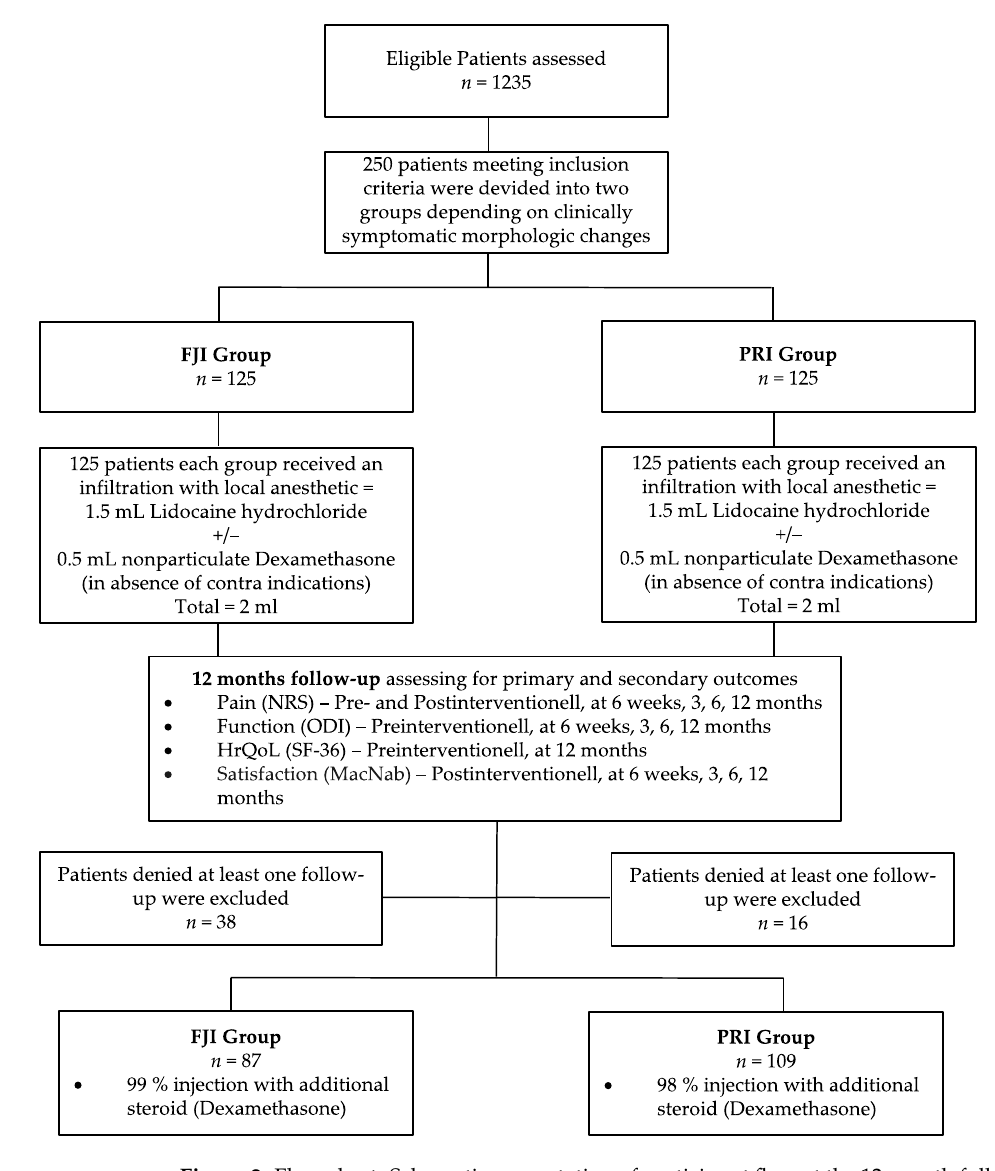
Figure 2. Flow chart. Schematic presentation of participant flow at the 12-month follow-up. FJI—facet joint capsule infiltration; PRI—periradicular infiltration therapy. Table 1. Baseline demographic and clinical